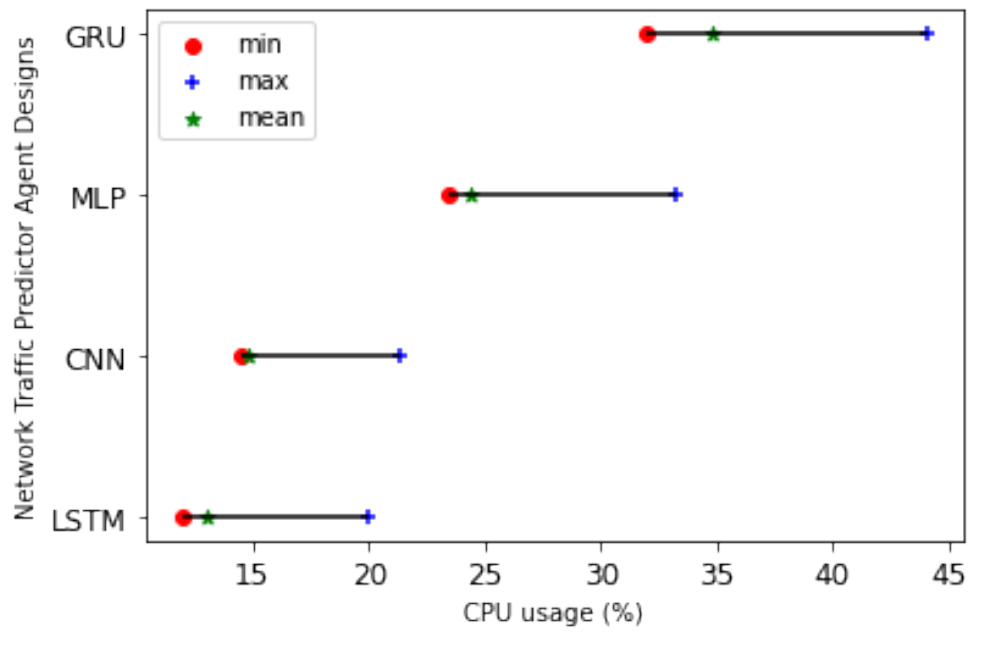
Figure 13. Comparison of NTPA memory usage.